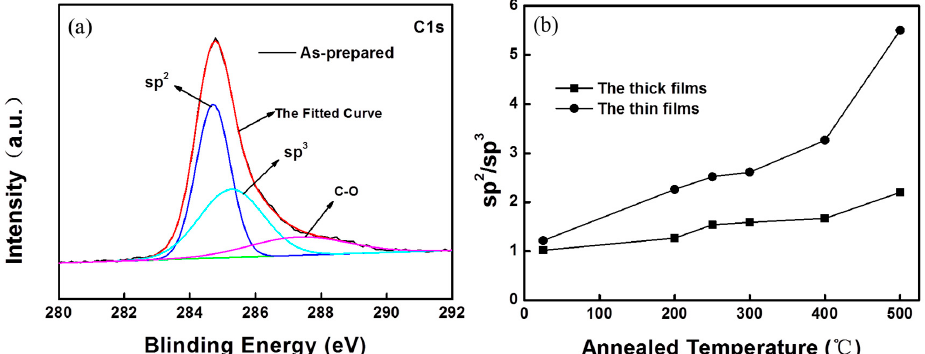
Figure 6. The fitted XPS C1s of original FL-C:H films ( a ), the values of sp 2 /sp 3 for thin and thick FL-C:H films at different annealed temperatures ( b ).